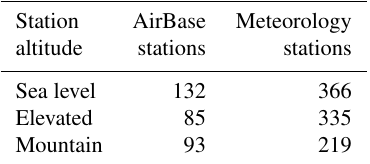
Table 1. The number of stations used in the analysis. Station AirBase Meteorology altitude stations stations